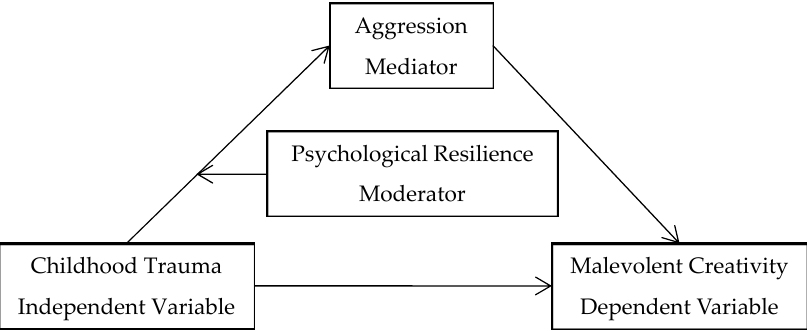
Figure 1. The hypothetical moderated mediation model.